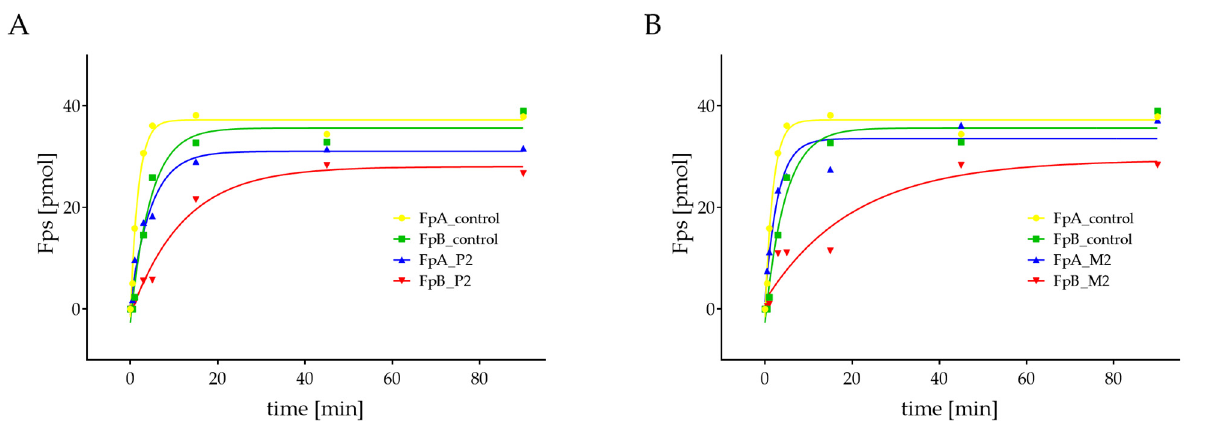
Figure 2. Measurement of patients´ Fps (blue and red) compared to controls (yellow and green). ( A ) P2 had prolonged cleavage and a decreased amount of FpB as well as M2 ( B ); Abbreviations: P2: patient 2; M2: mother of patient 2.